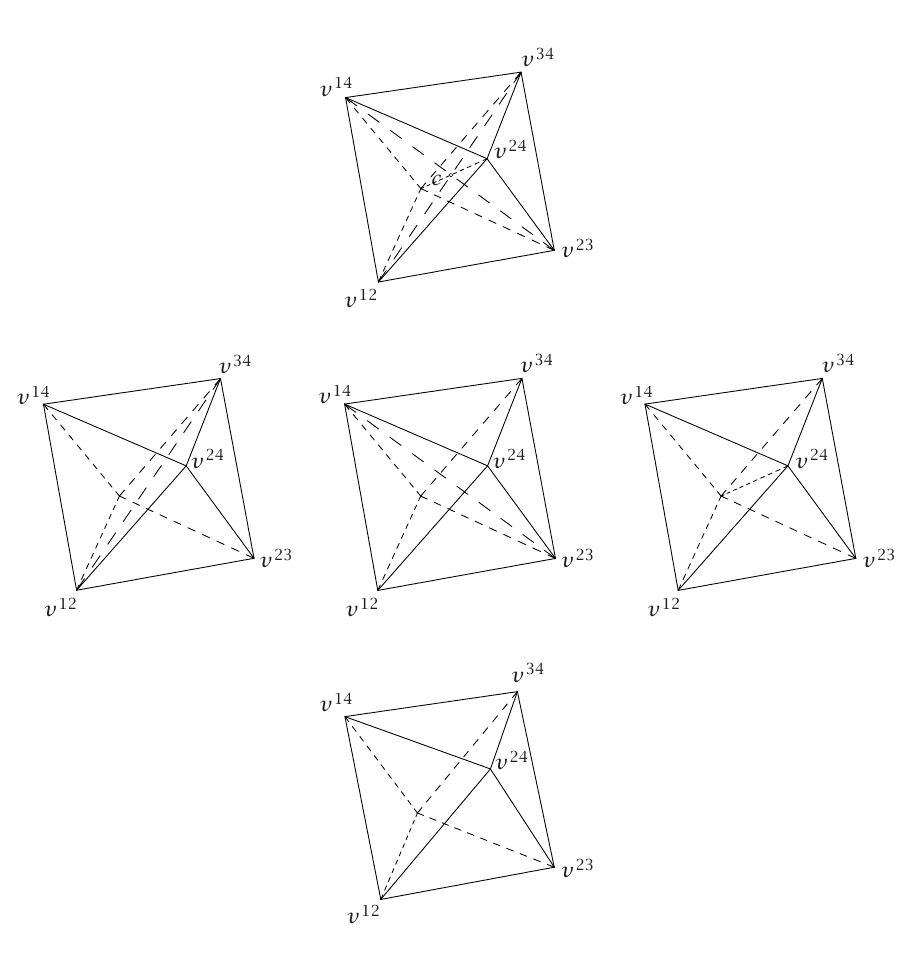
Figure 3.3 . Toric representation of 4-dimensional flops (in the second row), over a common singular base (in the third row), and dominated by the same 4-fold (in the first